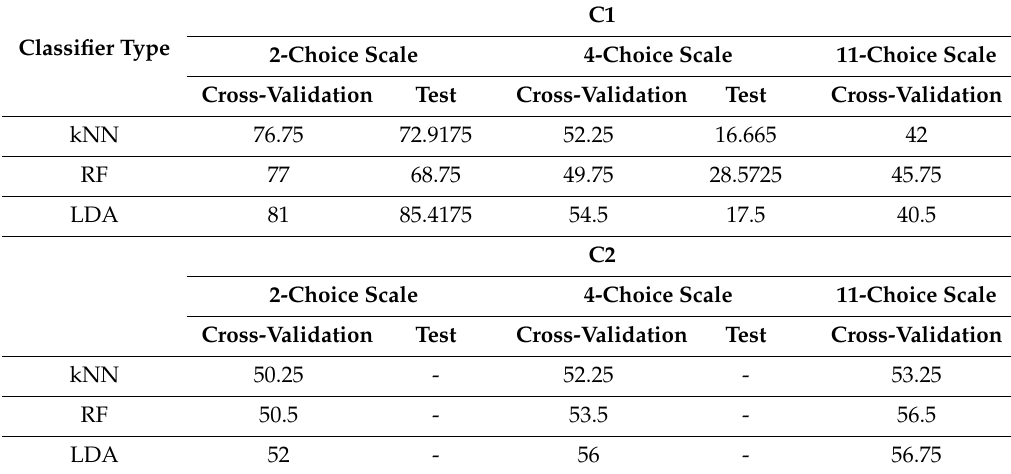
Table 7. Maximum cross-validation accuracy and test (validation) accuracy (in %) for the player-dependent modality, with SFS feature selection.